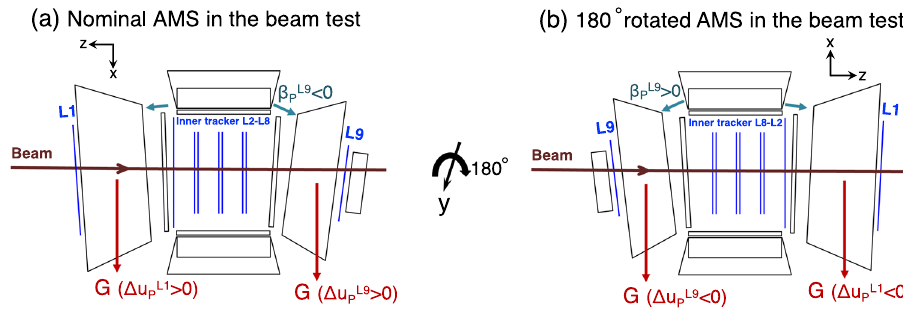
Fig. 7 Schematics of the detector deformations due to gravity for a nominal AMS and for b 180 ◦ rotated AMS in the beam test